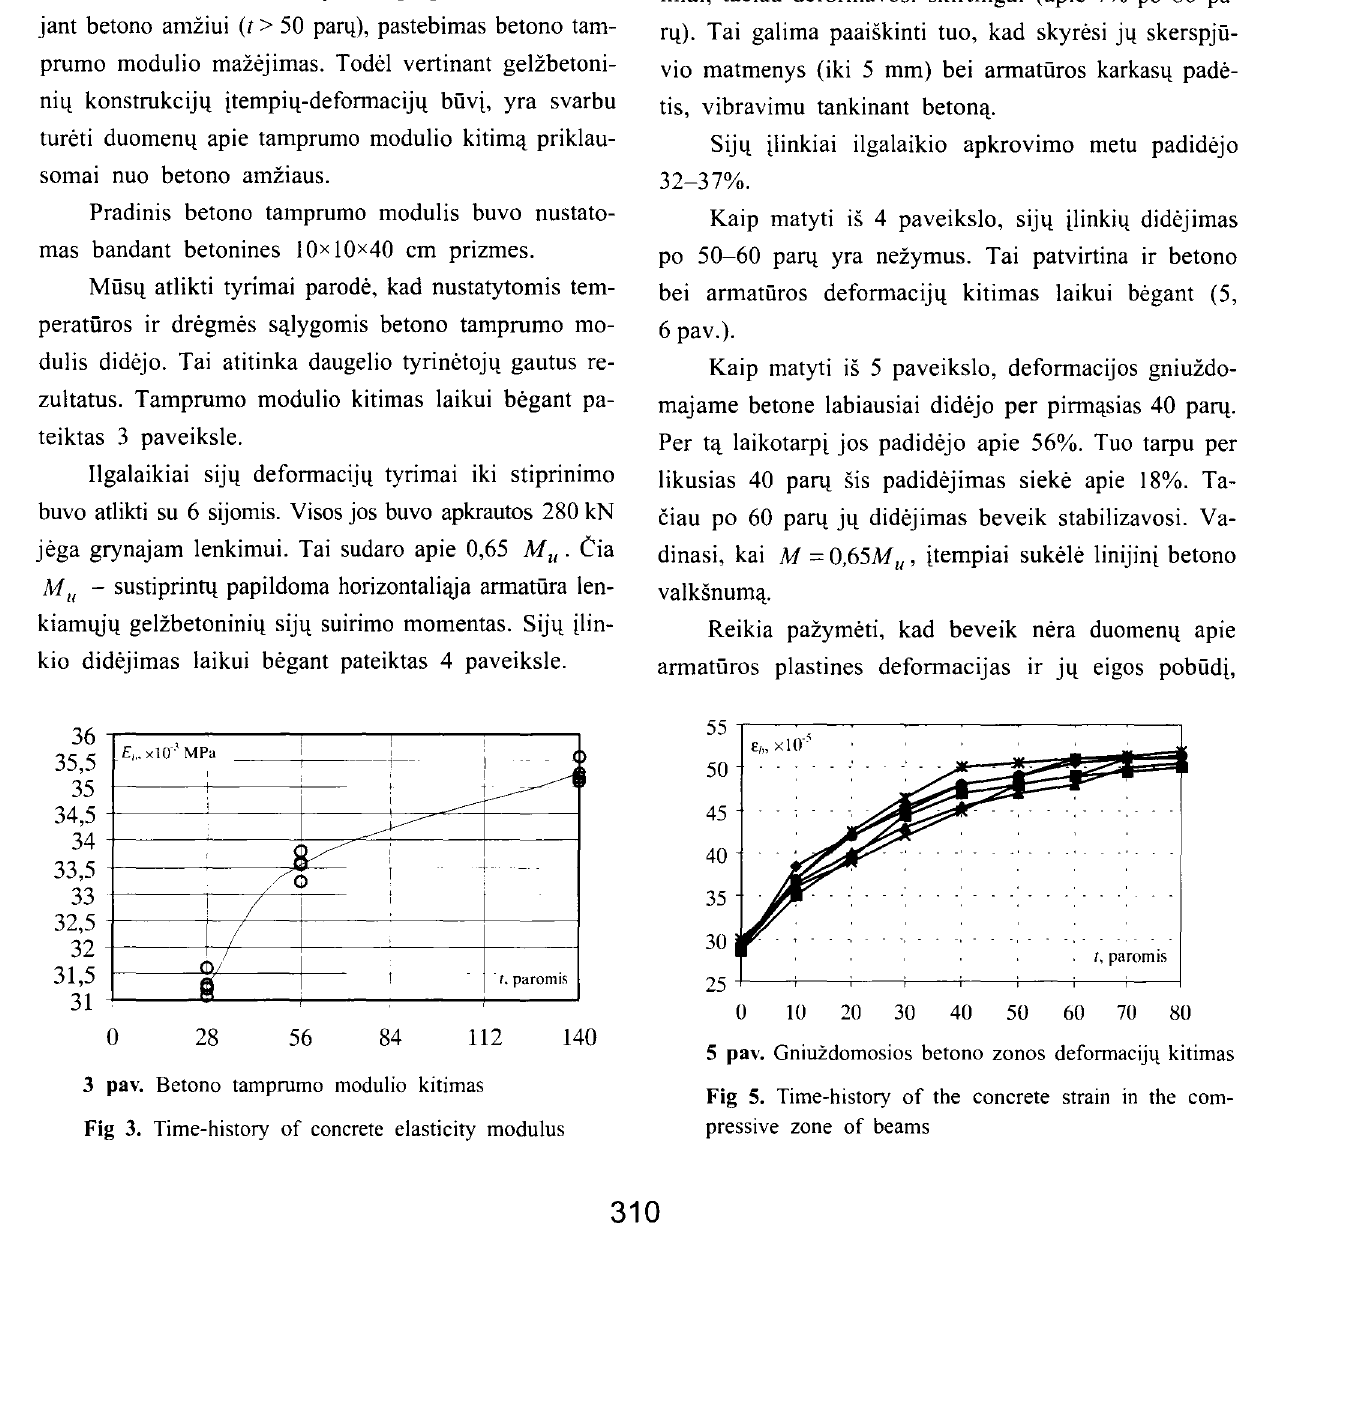
Fig 4. Time-history of the deflection of the experimen tal beams exposed to a long-term load